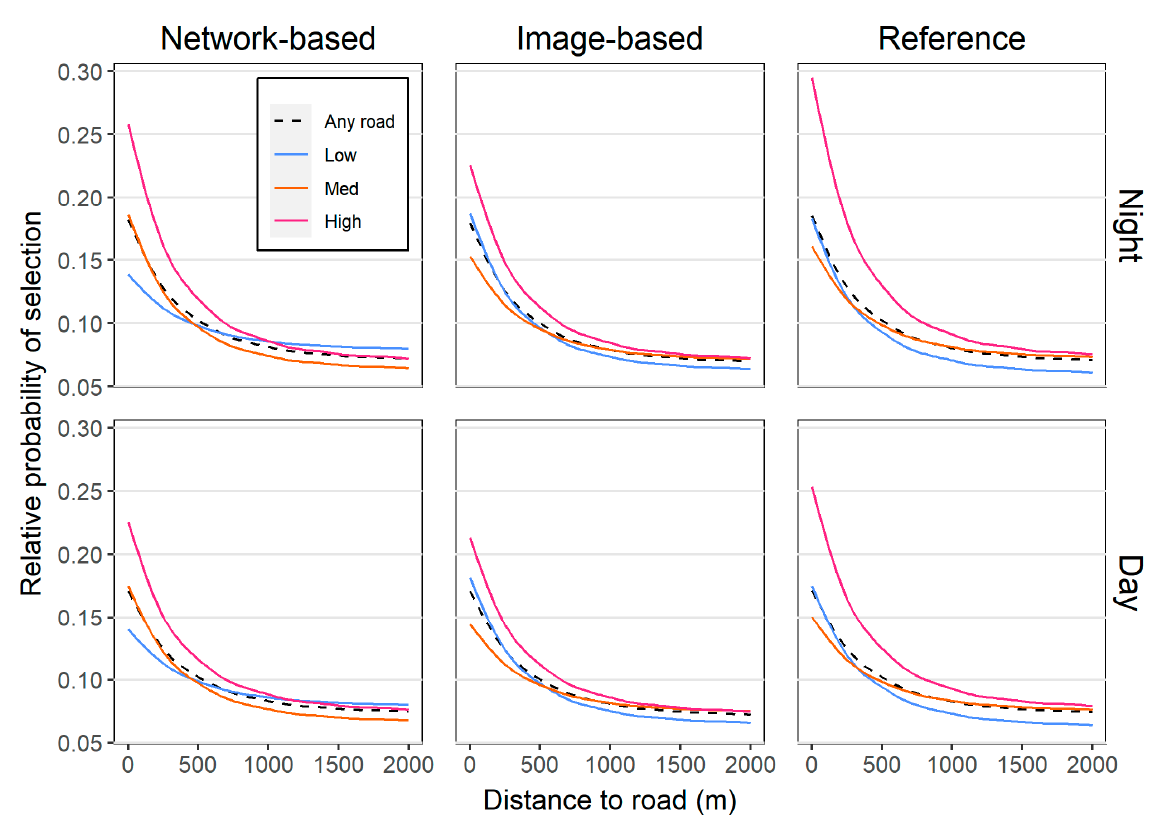
Figure 6. The relative probability of grizzly bear habitat selection as a function of road distance at the 2000 m scale by time of day (rows), classification method (columns) and whether roads were classified (colored lines; Low, Medium, or High human activity) or non ‐ classified (dashed line; Any road).